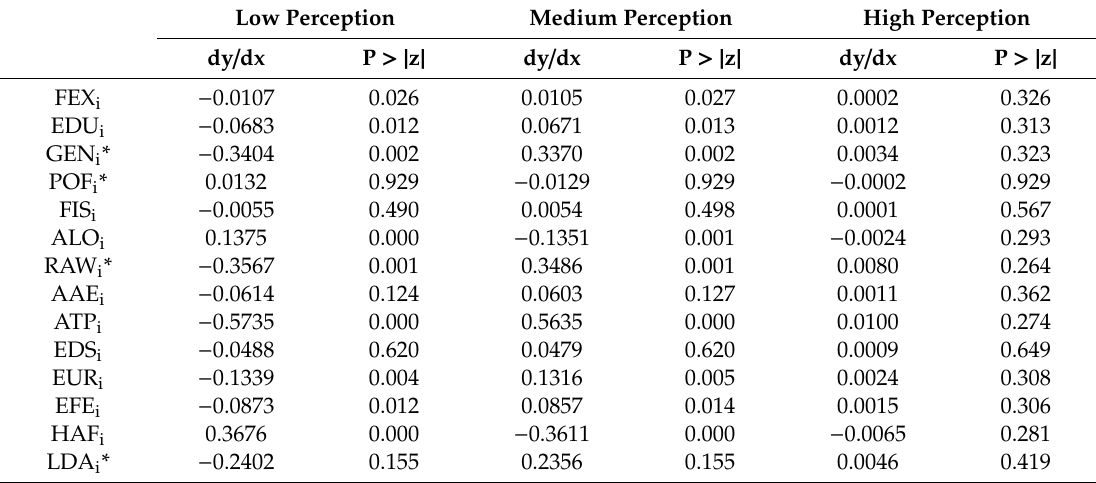
Table 8. Marginal e ff ects of ordered probit models for irrigated-farm